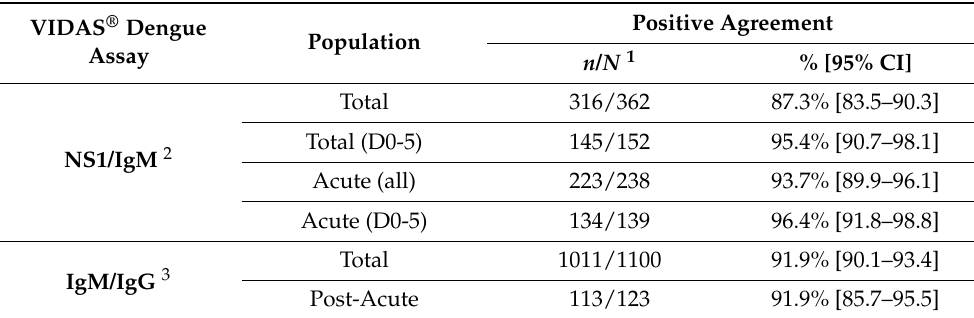
Table 11. Positive agreement of combined NS1/IgM and IgM/IgG VIDAS ® dengue assays with the respective competitor ELISA, in the total, acute (NS1/IgM) and post-acute (IgM/IgG) stage of DENV